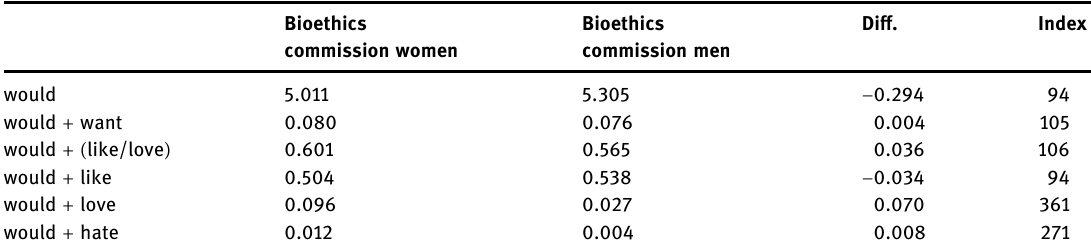
Table 8: Frequency of collocation of “ would ” with verbs of desire and aversion, as per cent of total tokens ( normalised, n = 1,000 )